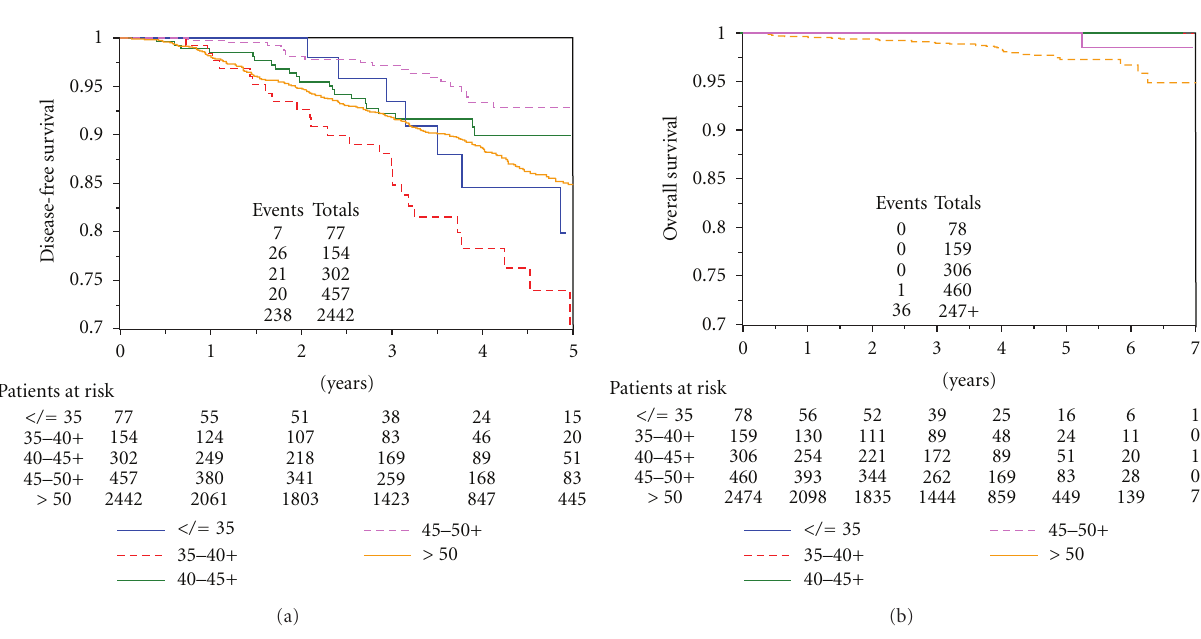
Figure 1: (a) Disease-free survival (DFS), and (b) overall survival (OS) according to age